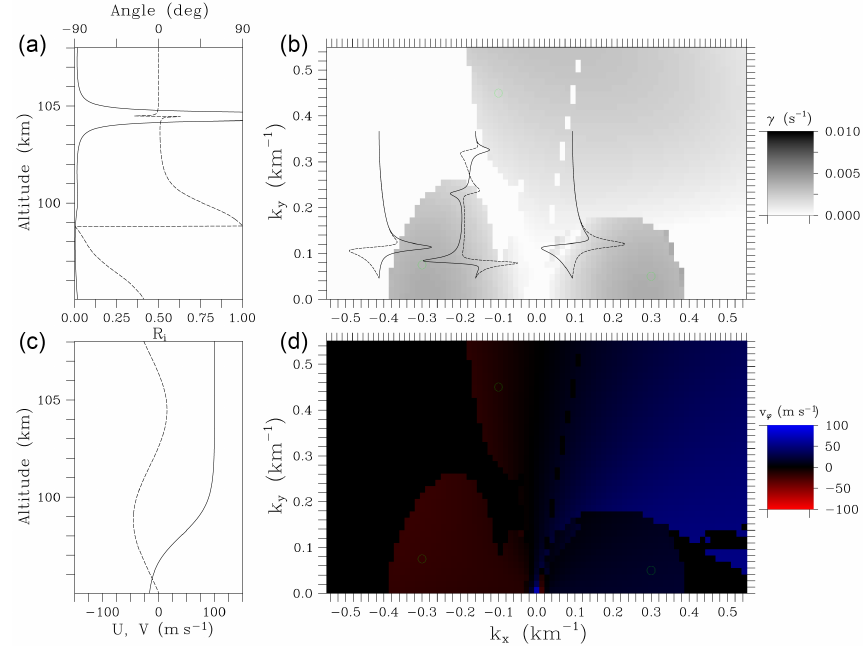
Figure 8. Same as Fig. 7 except for the second E s -layer